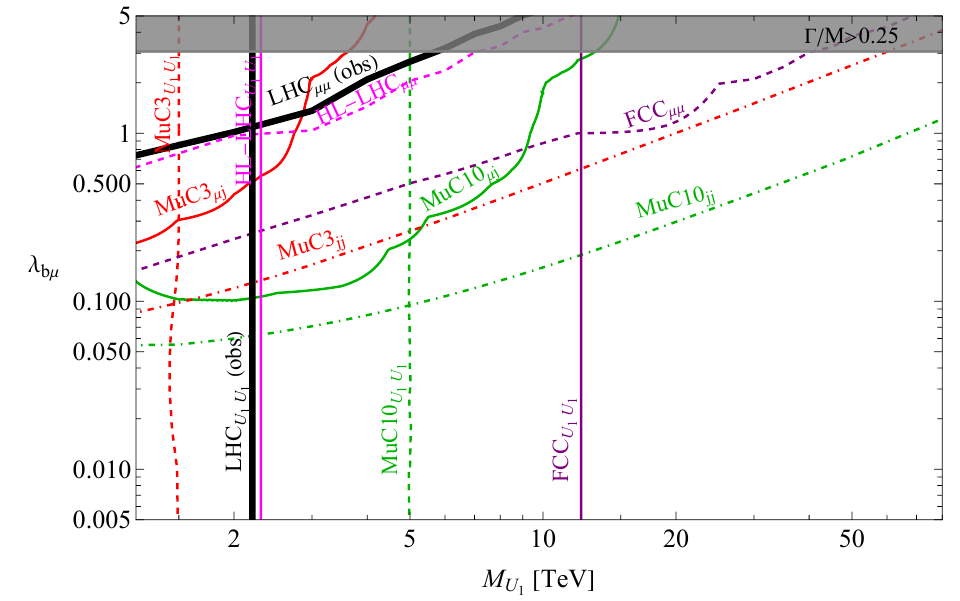
Figure 15 . Discovery reach at 5 σ for the U 1 leptoquark in the U(2) 3 symmetric case. The present 95%CL exclusion by LHC is shown as a thick black line. In the grey region, the perturbativity criterion Γ U /M U < 0 . 25 is 1 1